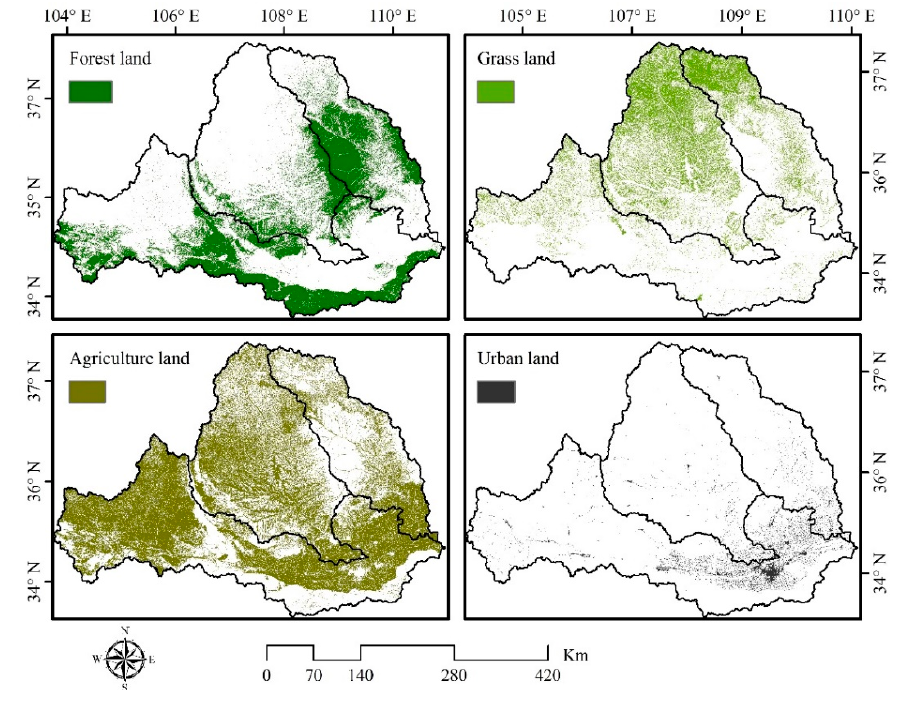
Figure 4. Distribution of the four land use types in the Wei River basin.